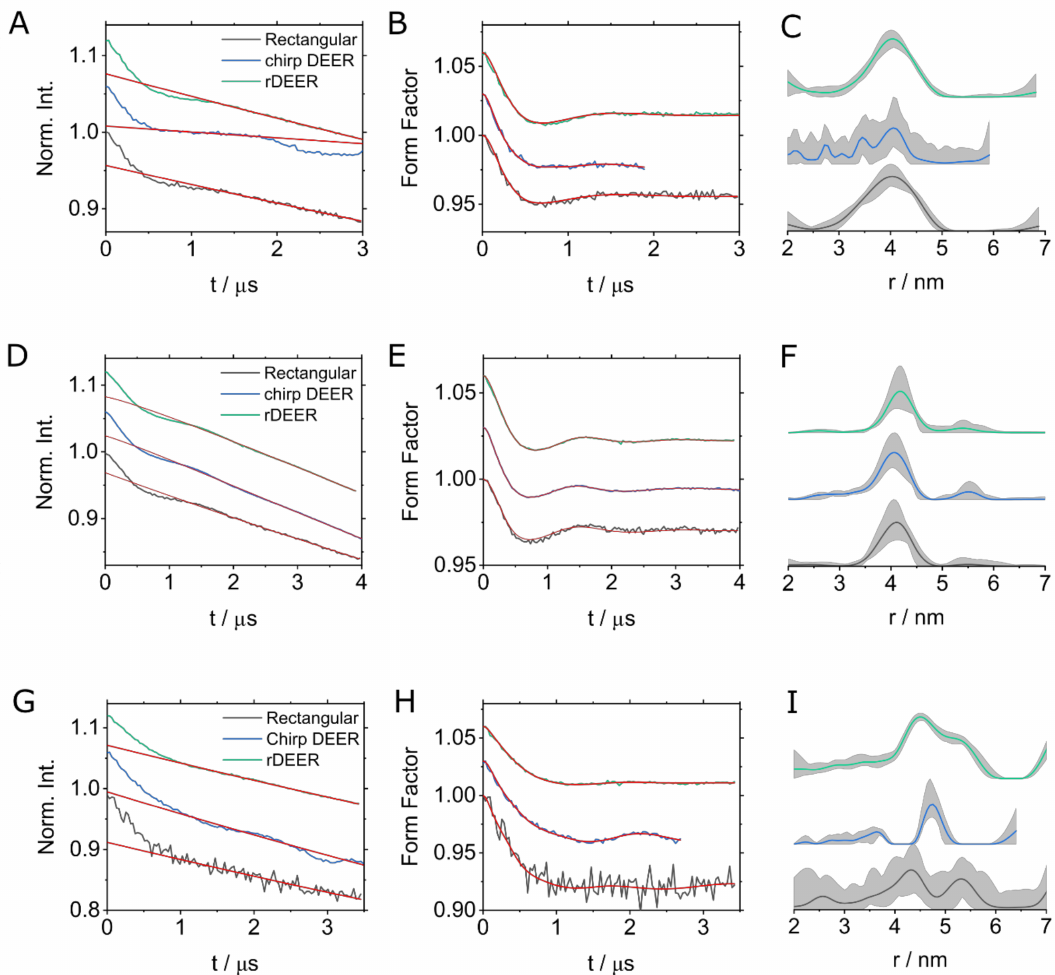
Figure 4. Comparison of the DEER data of Ubi-DOTA-M-Gd (top panels), Ubi-DO3A-Gd (center panels), and MdfA-C2-Gd (bottom panels) with rectangular DEER, chirp DEER, and the rDEER experiment; ( A , D , G ) Raw data with the background correction function (red traces); The artifact is clearly visible at 2–3 µ s for the chirp DEER sequence (blue trace) in ( A ) and from 2.5 µ s to 3.3 µ s in ( G ) and disappears with the use of the rDEER sequence (green trace); ( B , E , H ) Background-corrected DEER data and fit obtained with the distance distributions shown in ( C , F , I ) using Tikhonov regularization and DeerAnalysis (red traces) [50]. Confidence intervals using DeerAnalysis’ built-in validation function are shown in grey. Within each sample, all data were accumulated on the same sample tube and with the same tuning. More details are given in Table 1. The regularization parameter α was kept constant within each sample and was 100 for ( C ), 12.6 for ( F ) and 20.0 for ( I ). Figure S3 shows the DeerAnalysis’ color-coding of the distance reliability ranges of the data shown in ( C ), ( F ), and ( I